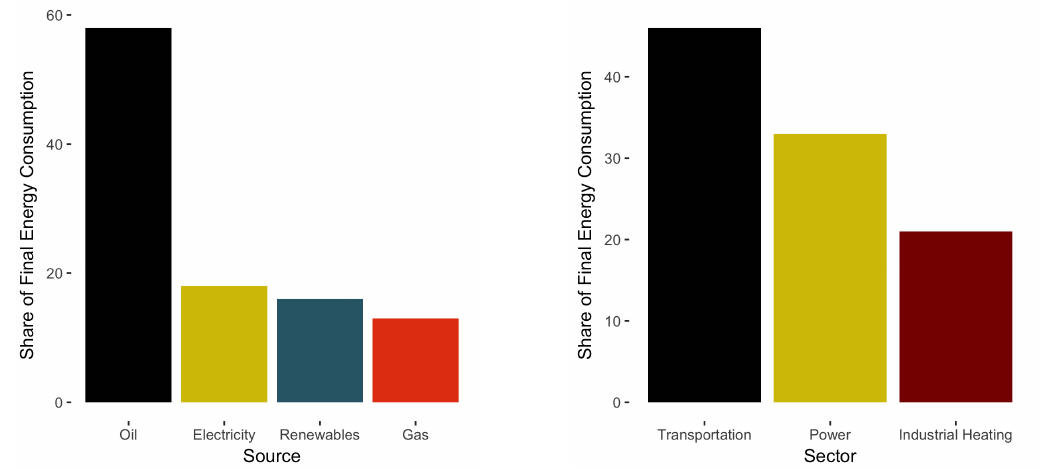
Figure 1. Percent Share of Final Energy Demand for Sources and